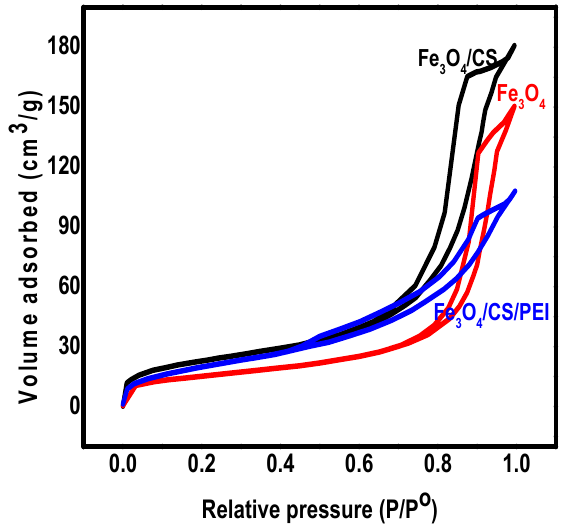
Figure 4. Nitrogen adsorption desorption isotherm of the synthesized Fe 3 O 4 NPs, Fe 3 O 4 /CS, and Fe 3 O 4 /CS/PEI nanomaterials.